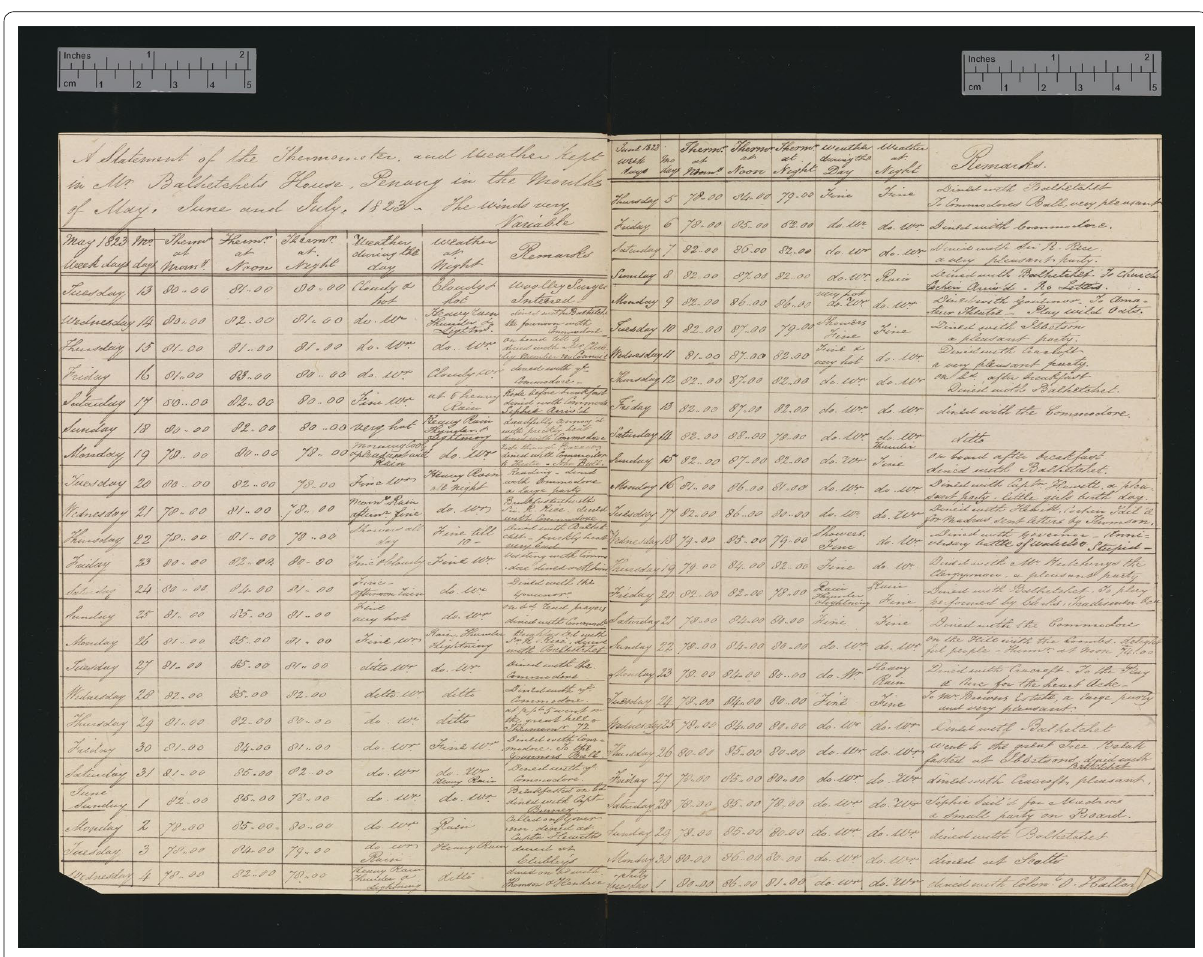
Fig. 2 Cambridge University Archive, MS. Add.7223: Extract from the private journal of Captain Thomas Alexander made between 1822 and